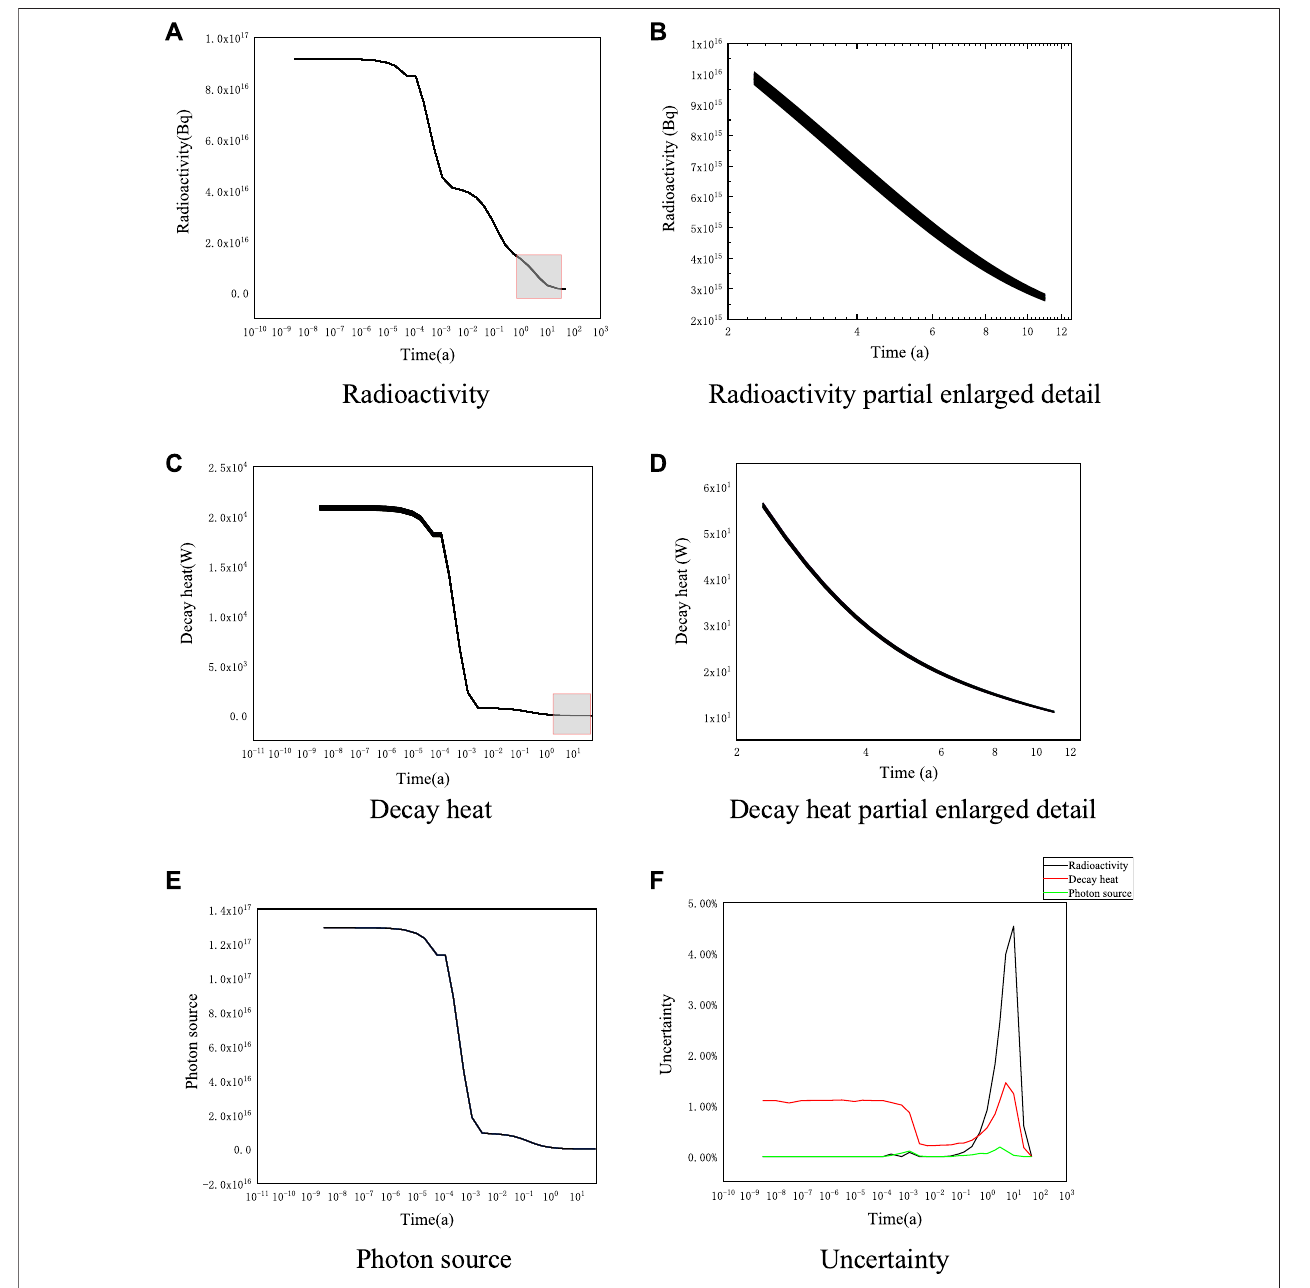
FIGURE 6 | NUREG/CR-6115 structural material radioactivity, decay heat and photon uncertainty. (A) Radioactivity (B) Radioactivity partial enlarged detail (C) Decay heat (D) Decay heat partial enlarged detail (E) . Photon source (F) Uncertainty.